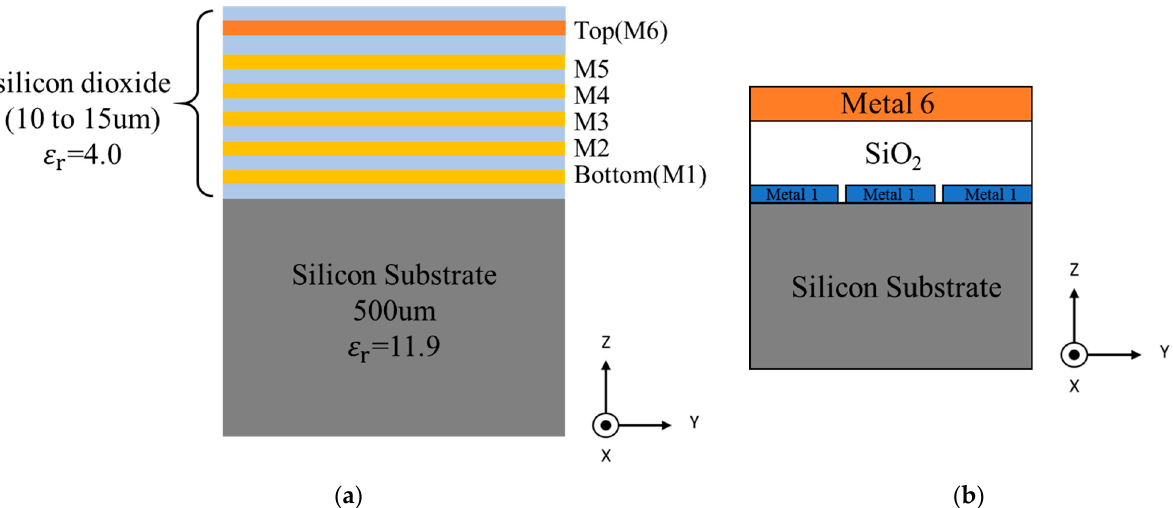
Figure 1. Layer stack of a typical six-metal-layer TSMC 0.18 μ m CMOS process: ( a ) Cross-section view of the adopted TSMC 0.18 μ m CMOS process; ( b ) The number of layers used in the antenna design on this chip.